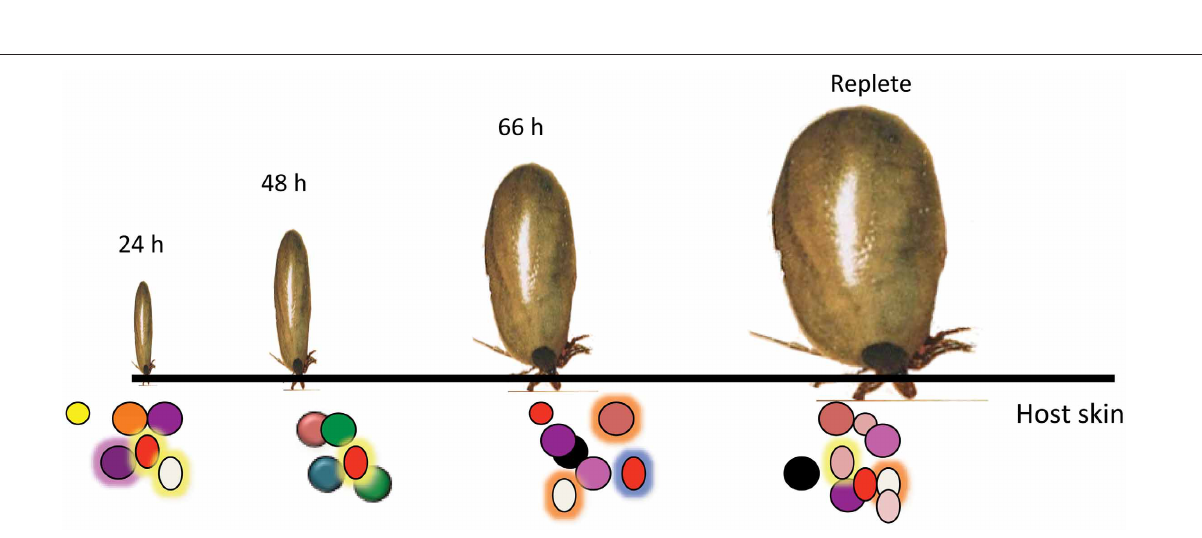
saliva into the host dermis at the bite-site. Salivary composition potentially changes during feeding to confront the different host defense